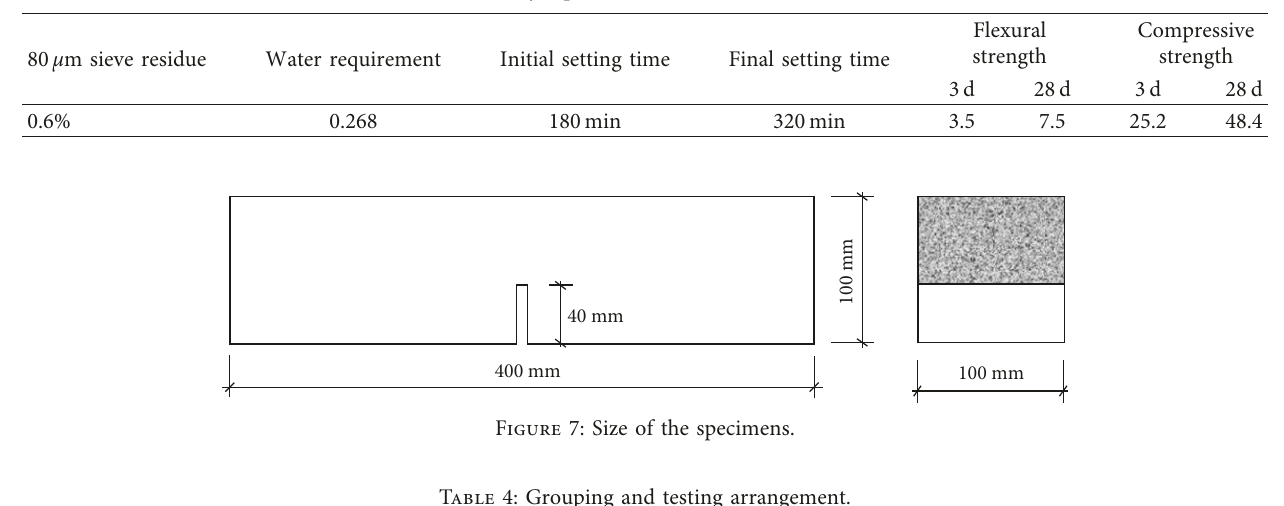
Table 3: The major performance of the PO 42.5R cement.